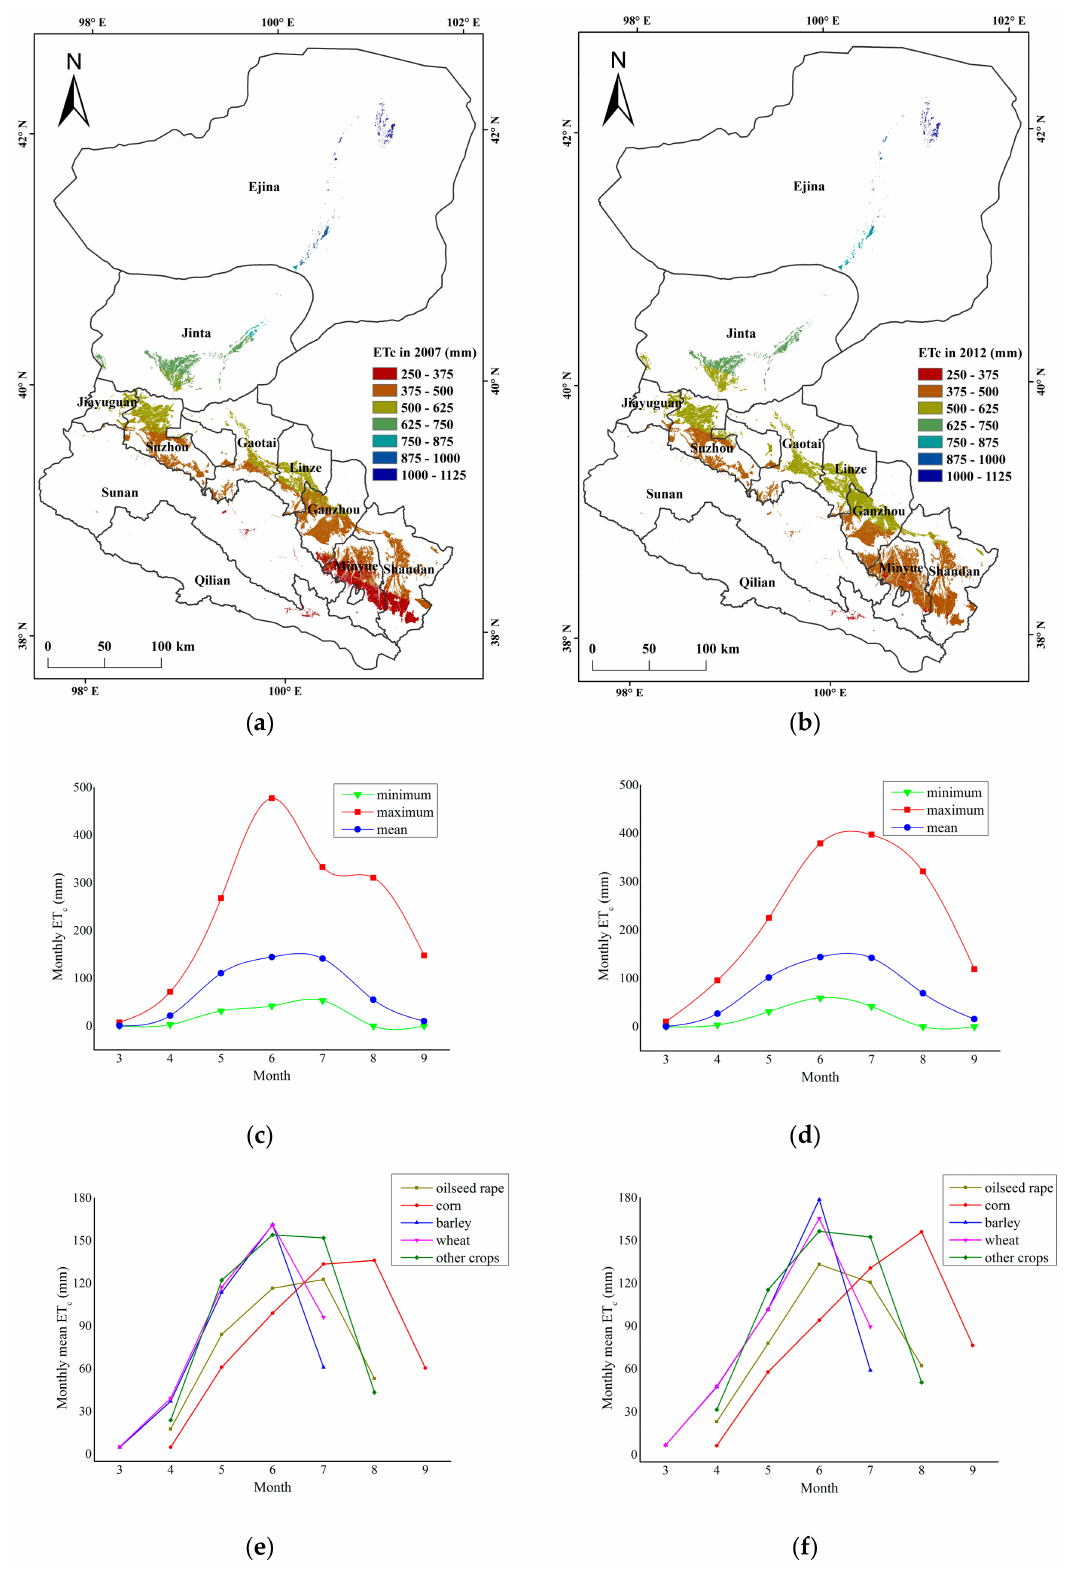
Figure 4. HRB ET c values for 2007 and 2012: ( a ) Spatial distribution of ET c in 2007; ( b ) Spatial distribution of ET c in 2012; ( c ) Monthly mean, maximum, and minimum ET c for 2007; ( d ) Monthly mean, maximum, and minimum ET c for 2012; ( e ) Monthly mean ET c of different crops in 2007; ( f ) Monthly mean ET c of different crops in